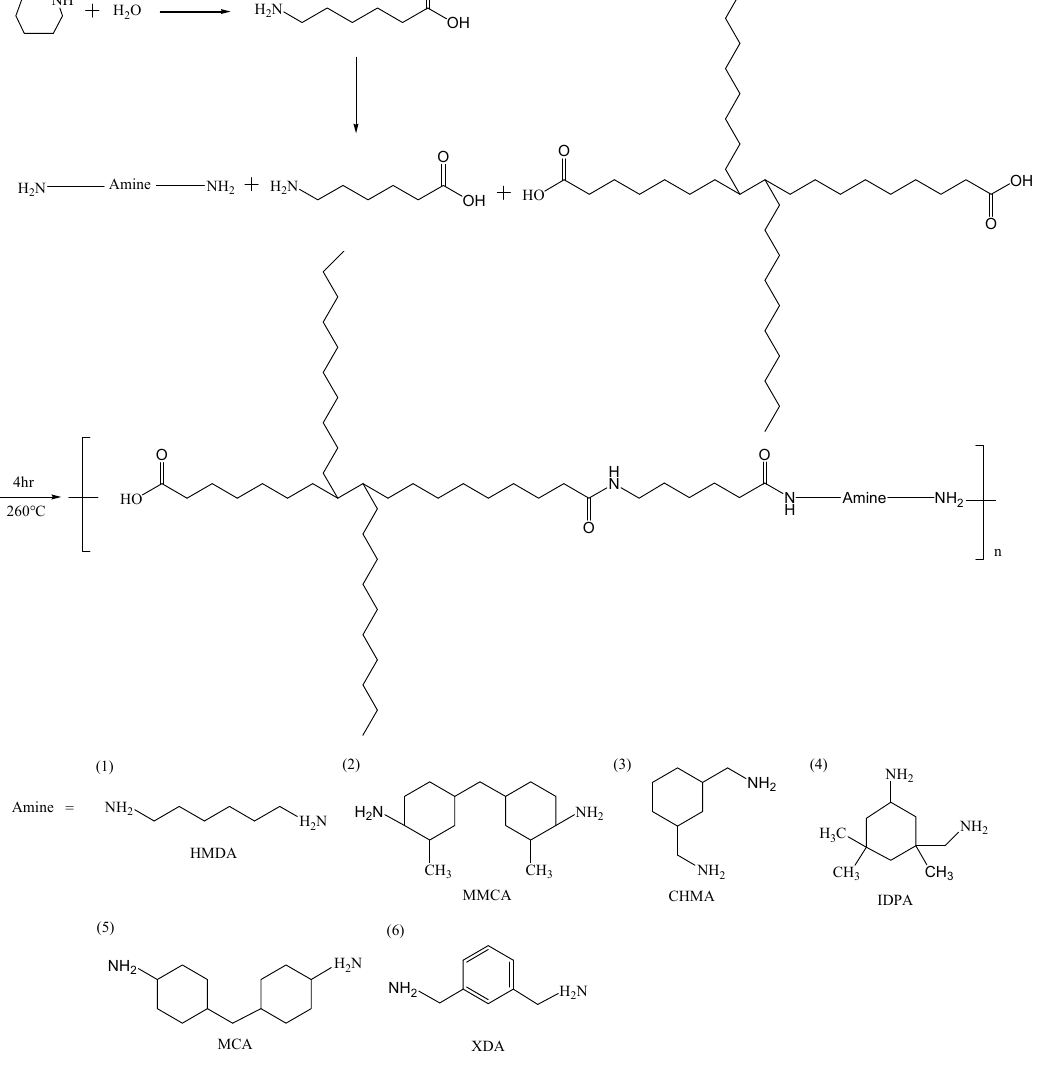
Figure 1. Synthesis of PA6 containing cyclic compounds.